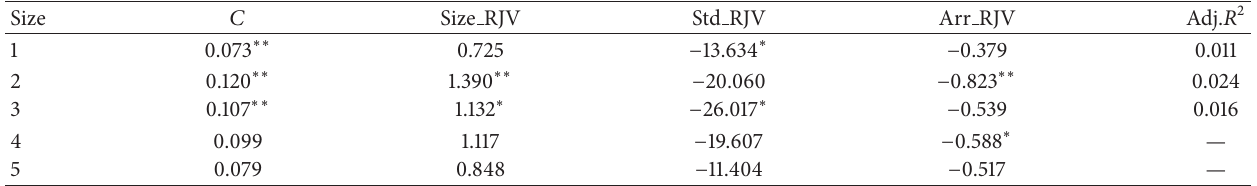
Table 7: Forecasting one-month-ahead individual-based portfolio returns using realized jump volatility-based factor model.